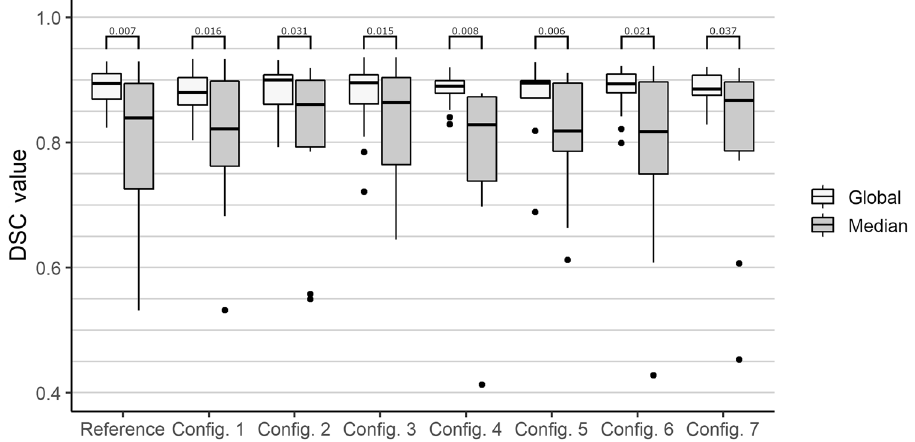
Figure 5. Results of the robustness analysis. Configuration (Config.) 1–5 represent the variation of the number of orientations. Configuration 6 and 7 represent the variation of optimization parameters. Global = globally optimized threshold. Median = Median from the optimized thresholds of each of the eight image orientations. Horizontal lines indicate statistically significant post-hoc pairwise t-test results. No values are located below a DSC of